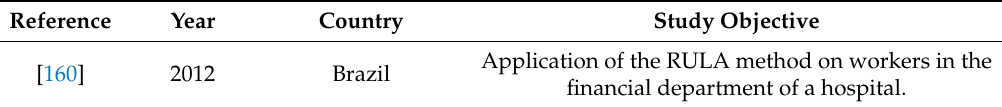
Table 12. Financial and insurance activities.